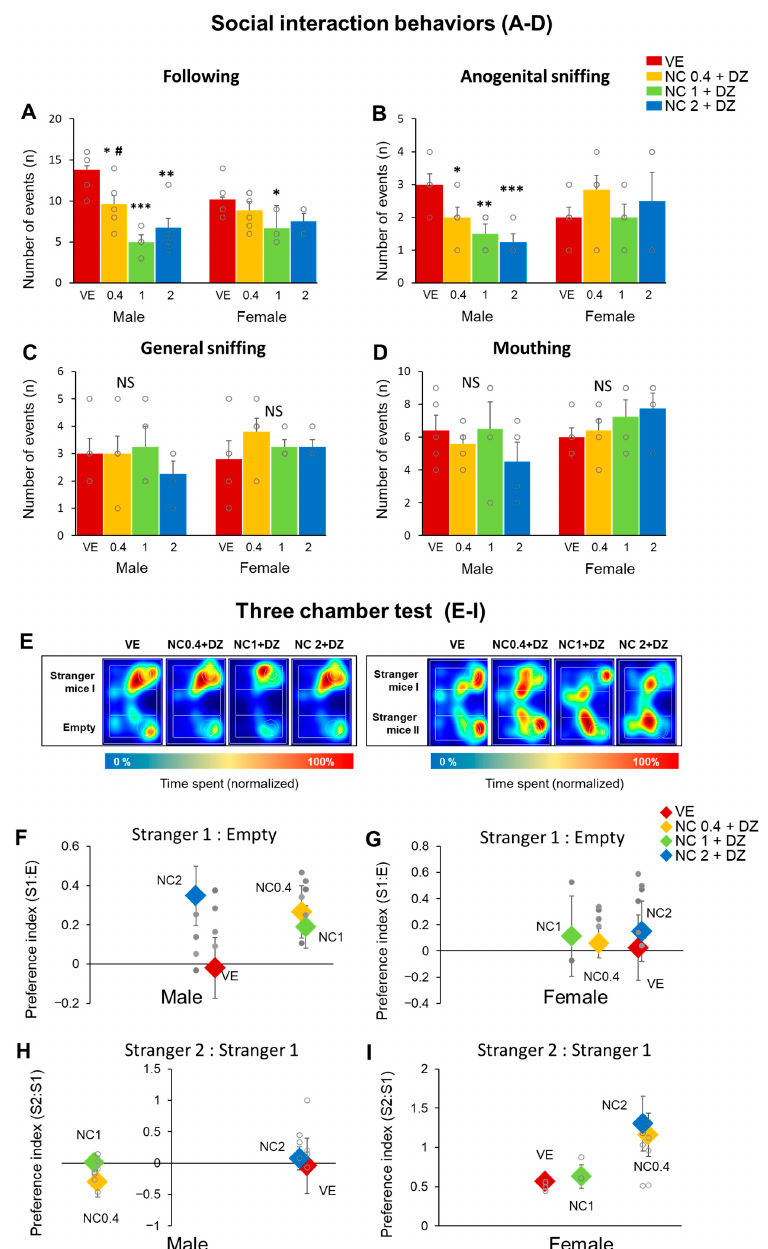
Figure 5. Combined administration of nicotine and diazinon influenced mouse social interaction behaviors, but not influenced on three-chamber social interaction. ( A – D ), social interaction test results. ( A ), following behavior, male mice in all three chemical-treated group showed lower following behavior (* p < 0.05, ** p < 0.01, *** p < 0.001 vs. VE, # p < 0.05 NC0.4 + DZ vs. NC1 + DZ, F 3,20 = 13.07, p < 0.0001), only NC1 + DZ treatment group exhibited significant reduction in following behavior (* p < 0.05 vs. VE, F 3,20 = 3.465, p = 0.038); ( B ), anogenital sniffing, nicotine and diazinon treatment resulted in decreased sniffing behavior in all three experimental group (* p < 0.05, ** p < 0.01, *** p < 0.001 vs. VE, F 3,20 = 10.45, p = 0.0003); while none of the female offspring show any changes in the test result; ( C ), general sniffing, there was no significant difference compared to VE in each group; ( D ), mouthing behavior, no statistical significance was detected; ( E ), Representative heat map images from three-chamber sociability test, ( F – I ), Preference indexes were calculated from three chamber behavior. In male offspring, NC0.4 + DZ and NC2 + DZ exposure group indicated the tendency to not prefer to stranger mice, but statistical significances were not detected. VE, vehicle-treated group; NC0.4 + DZ, 0.4 mg/kg nicotine and 0.18 mg/kg diazinon-treated group; NC1 + DZ, 1 mg/kg nicotine and 0.18 mg/kg diazinon-treated group; NC2 + DZ, 2 mg/kg nicotine and 0.18 mg/kg diazinon-treated group. Data are presented as the means ± standard error of the mean. Statistical significance was determined by one-way ANOVA with the Tukey’s correction